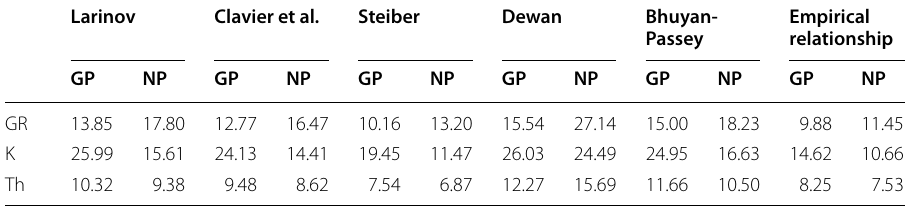
Table 5 The average weight percent clay contents from the modified GR, K, and THOR